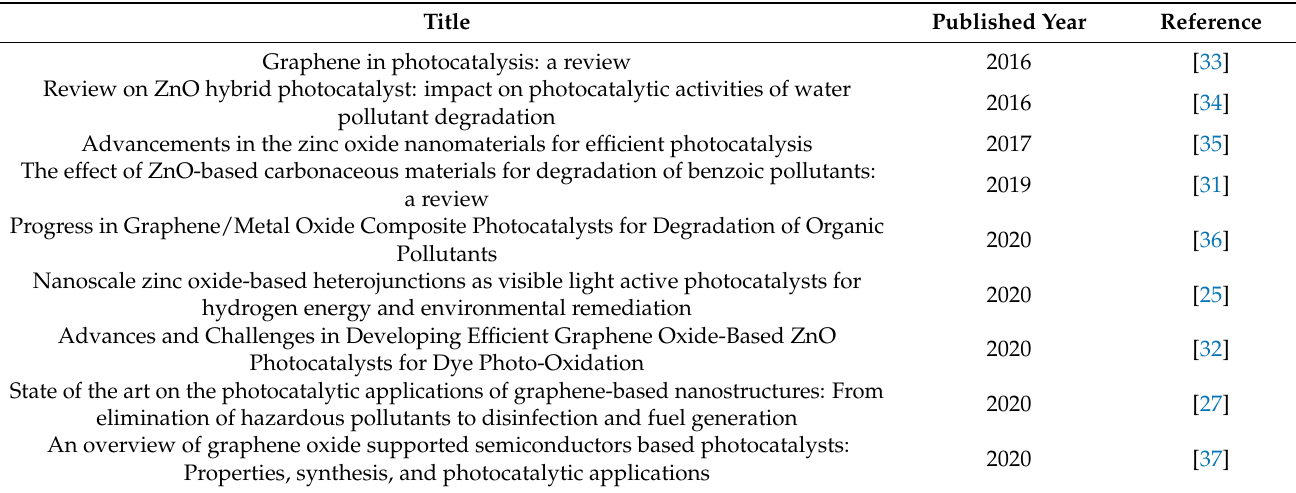
Table 1. Recent reviews of photocatalytic applications of semiconductor/graphene-based composites.